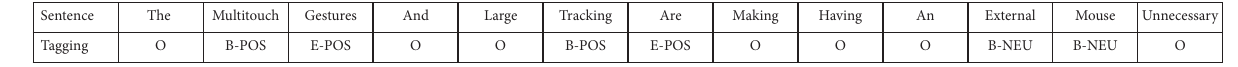
Figure 2: The sample tagging sentence in the laptop domain.